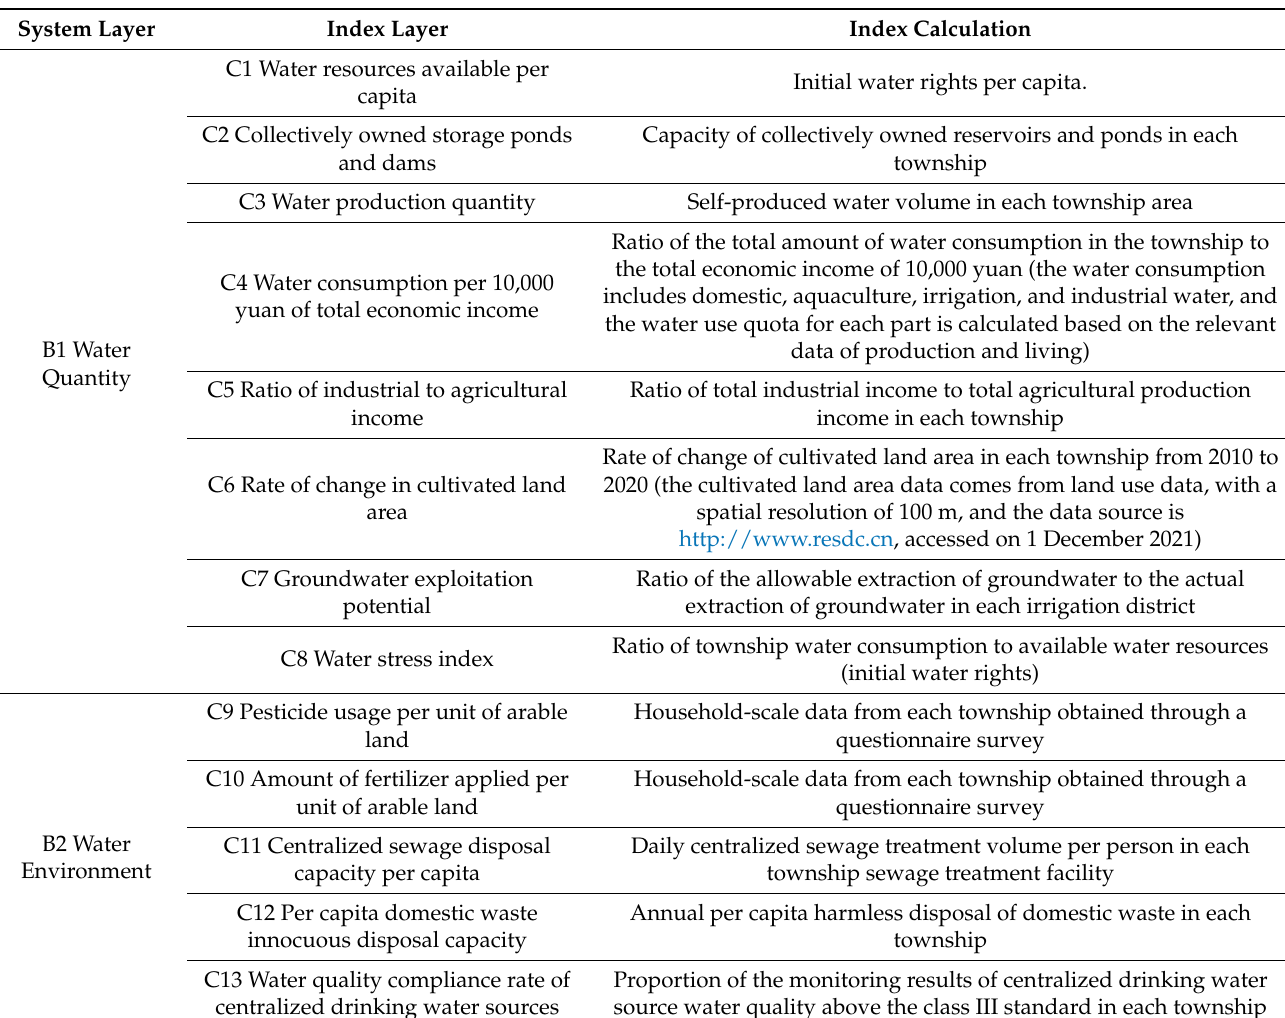
Table 2. Evaluation index system for the comprehensive carrying capacity of agricultural water resources in